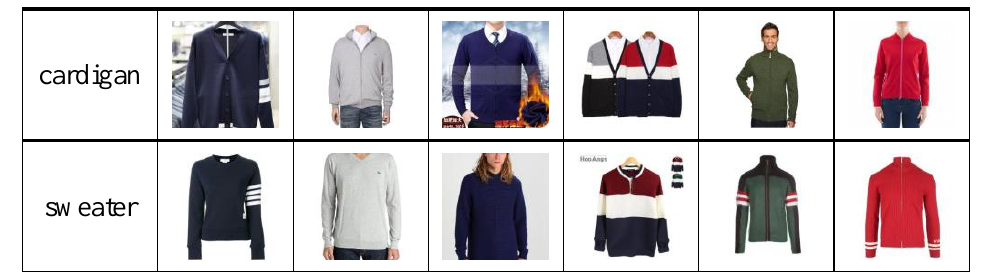
Figure 15. Training data set for cardigans and sweaters.